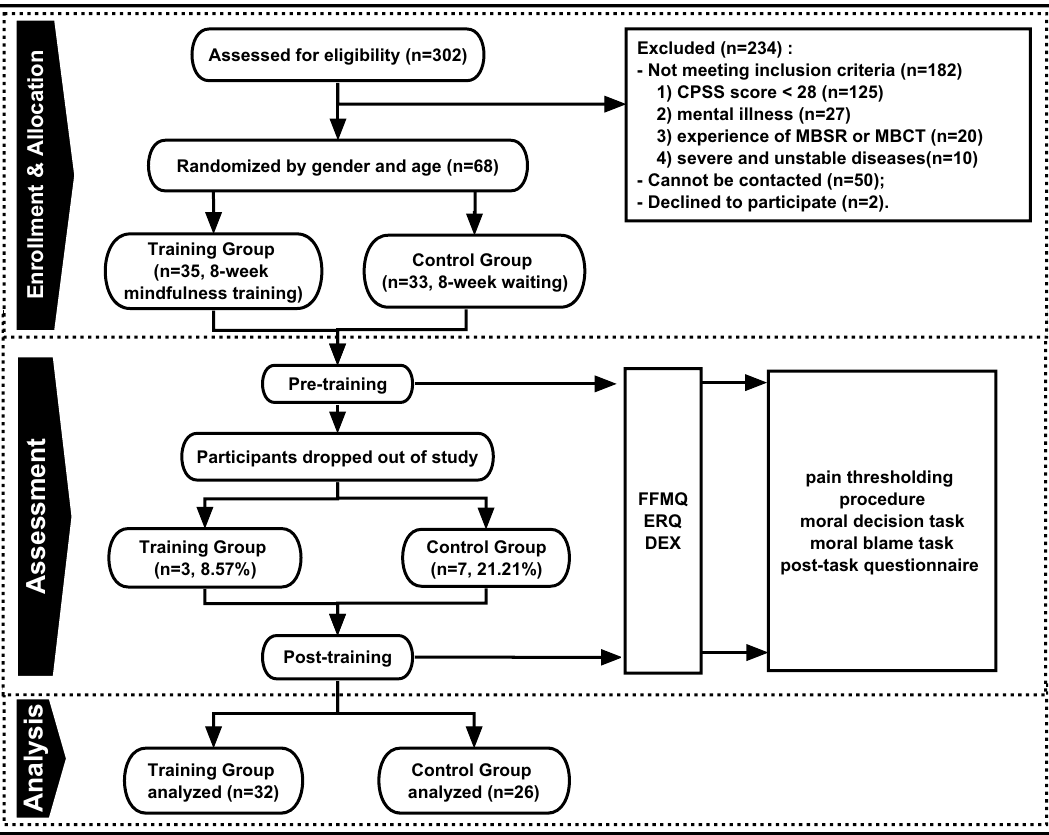
Figure 1. Flowchart of study design and